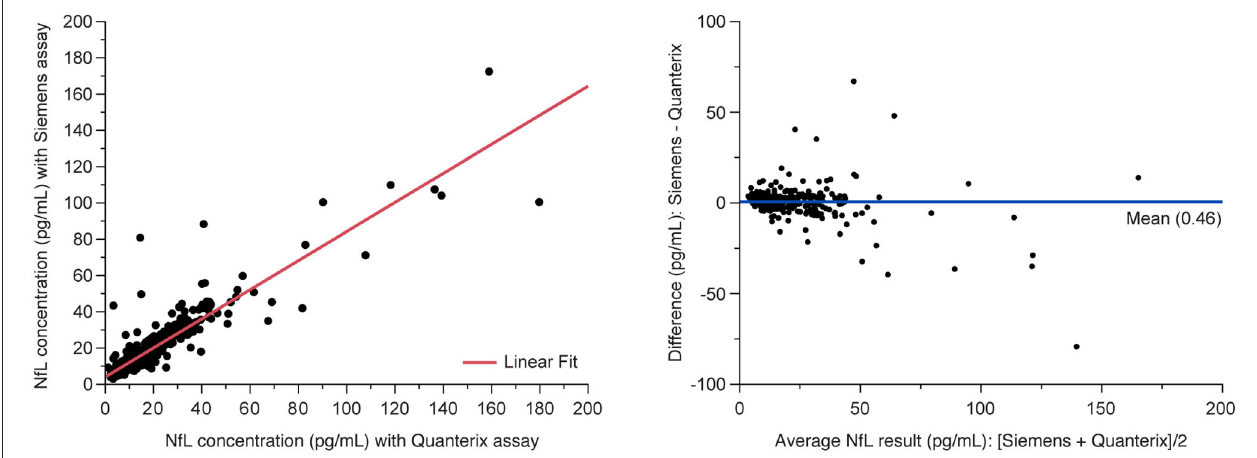
FIGURE 5 | Method comparison between Siemens assay and Quanterix SIMOA assay. (Left) Deming regression and (right) Bland-Altman plots of agreement between methods. Data are from the MS PATHS and ADVANCE studies, selected over the range of Quanterix sNfL results and sample availability. sNfL, serum neurofilament light